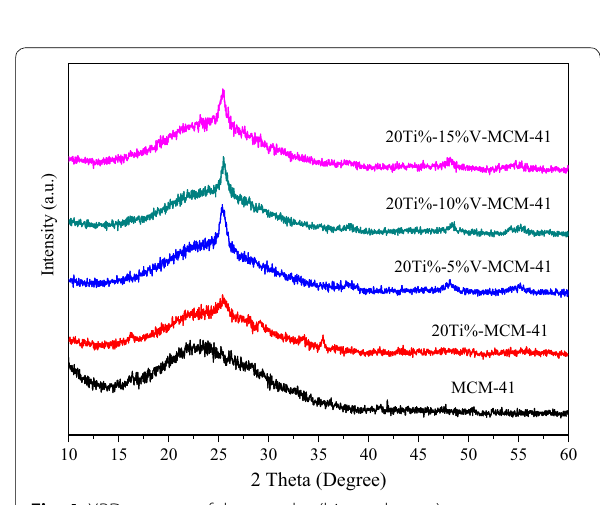
Fig. 4 XRD patterns of the samples (big angle